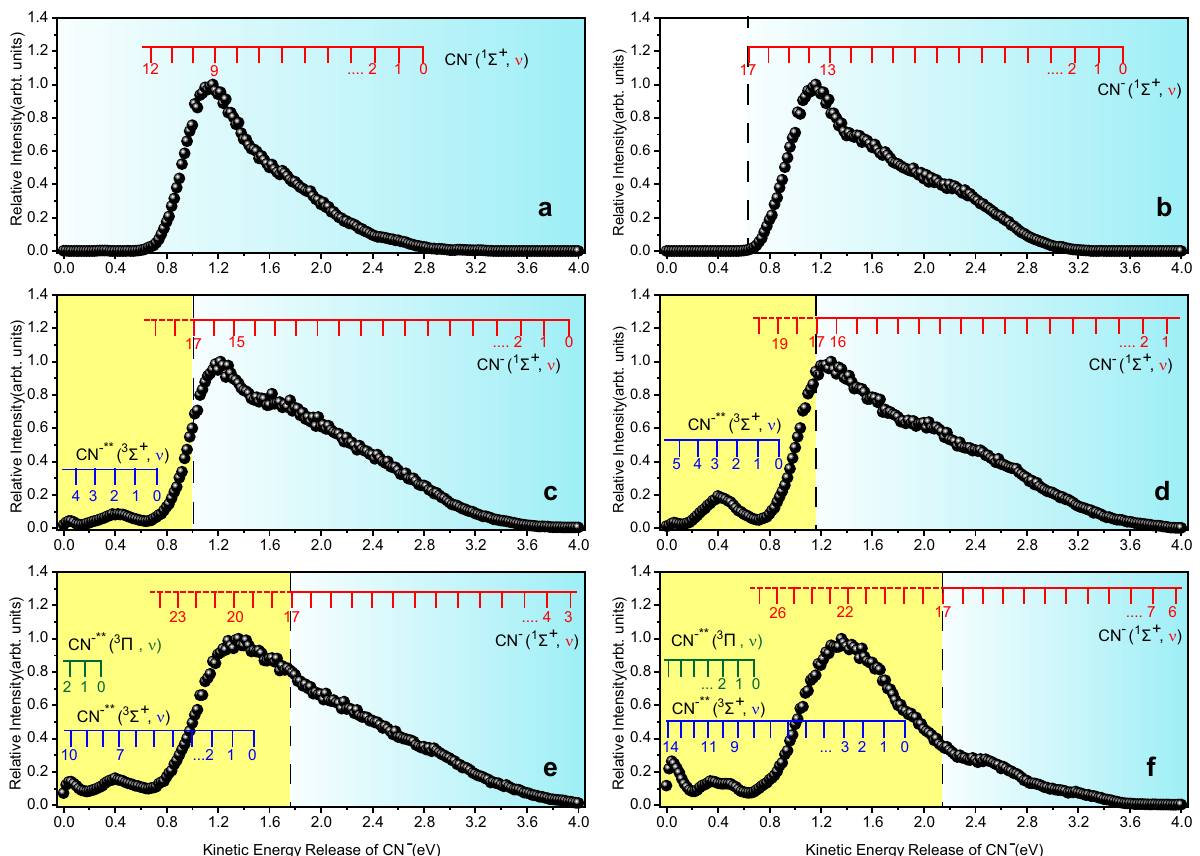
Fig. 3 Kinetic energy distributions of CN − . These CN − ions are produced in dissociative electron attachments to BrCN at 3.57 ( a ), 4.57 ( b ), 5.07 ( c ), 5.27 ( d ), 6.07 ( e ), and 6.57 ( f ) eV. The vibrational states of the ground ( 1 Σ + ) and superexcited ( 3 Σ + , 3 Π ) states are assigned for Br( 2 P 3/2 ) + CN − /CN − **, and two regions, the superexcited-state one (shaded in yellow) and the low vibrational state region of the ground-state 1 Σ + (shaded in cyan), are divided with a vertical dashed line which lies at the left side of 1 Σ + ( ν = 17) indicates the threshold of the electron autodetachment of CN −